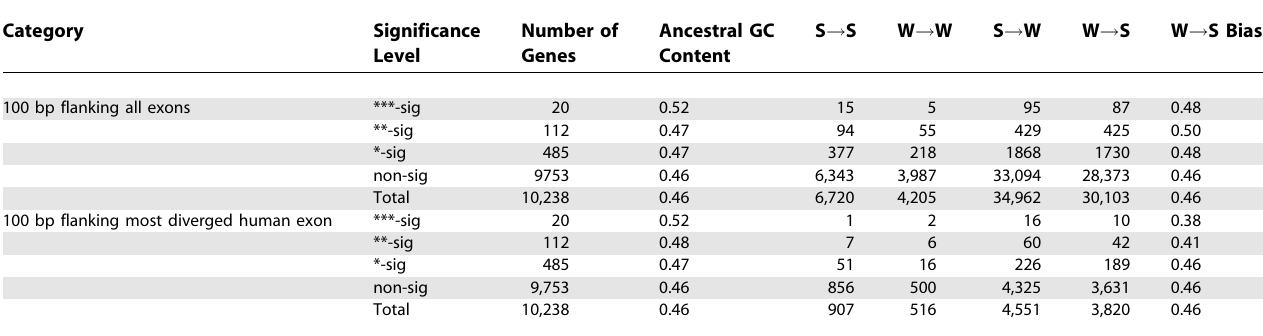
Table 6. Patterns of Nucleotide Substitution in Noncoding Regions Flanking Genes with Human-Accelerated d N /d S